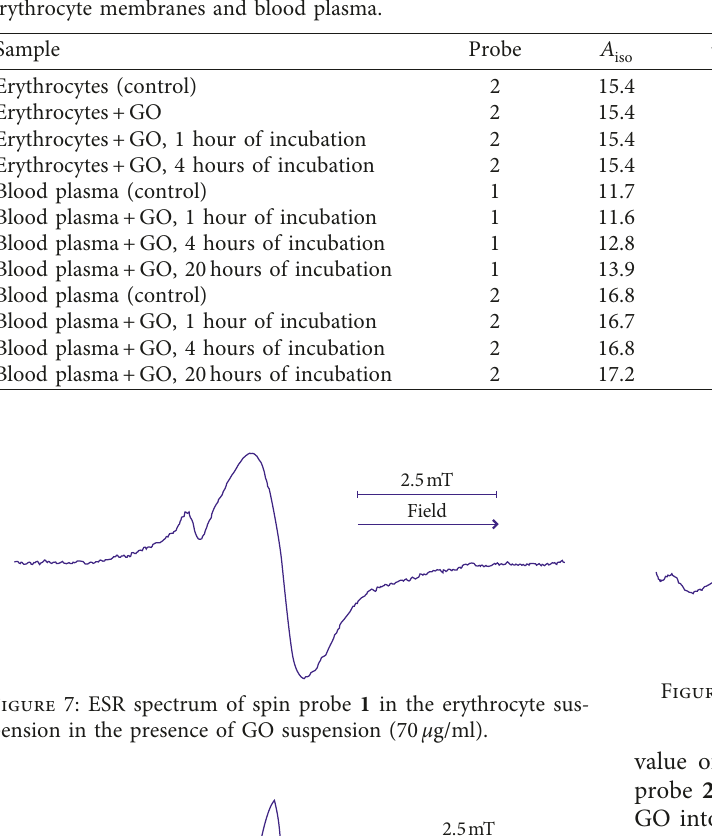
iso )) of spin probes 1 and 2 in the